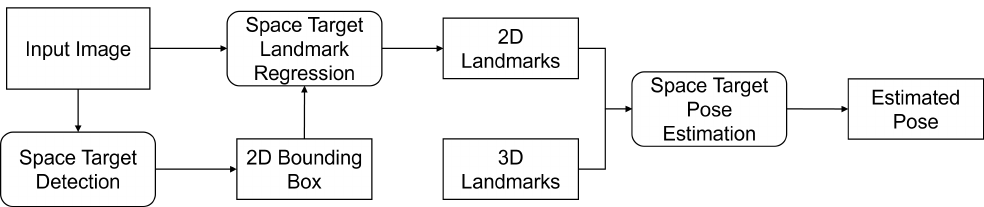
Figure 2. The overall pipeline of monocular vision-based known non-cooperative space target pose